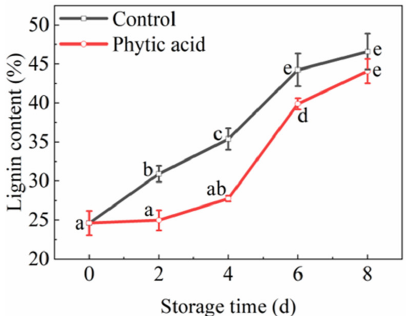
Figure 3. Lignification of fresh-cut apples during storage after treatment with phytic acid or the control. Vertical bars represent standard errors of the means of three replicates. The different letters indicate significant differences at p < 0.05.